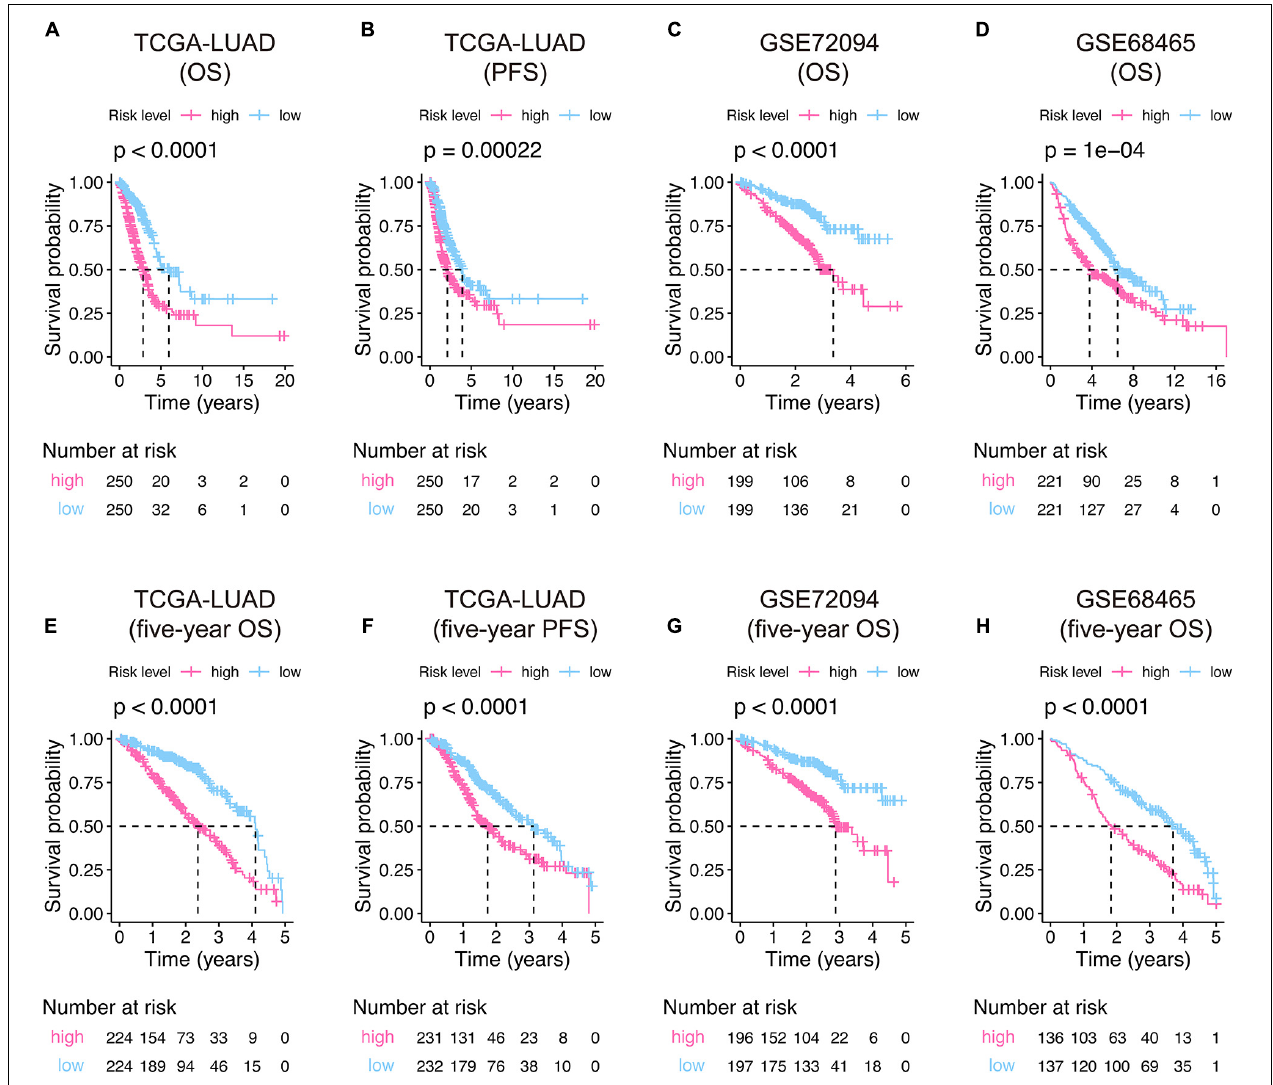
FIGURE 4 | Kaplan–Meier curves of the 15-gene signature risk score in the training (A,B,E,F) and validation (C,D,G,H) cohorts. The middle part of each graph indicates the number of patients at risk. The differences between the high- and low-risk groups were measured by the two-side log-rank test with a P -value < 0.05. OS, overall survival; PFS, progression-free